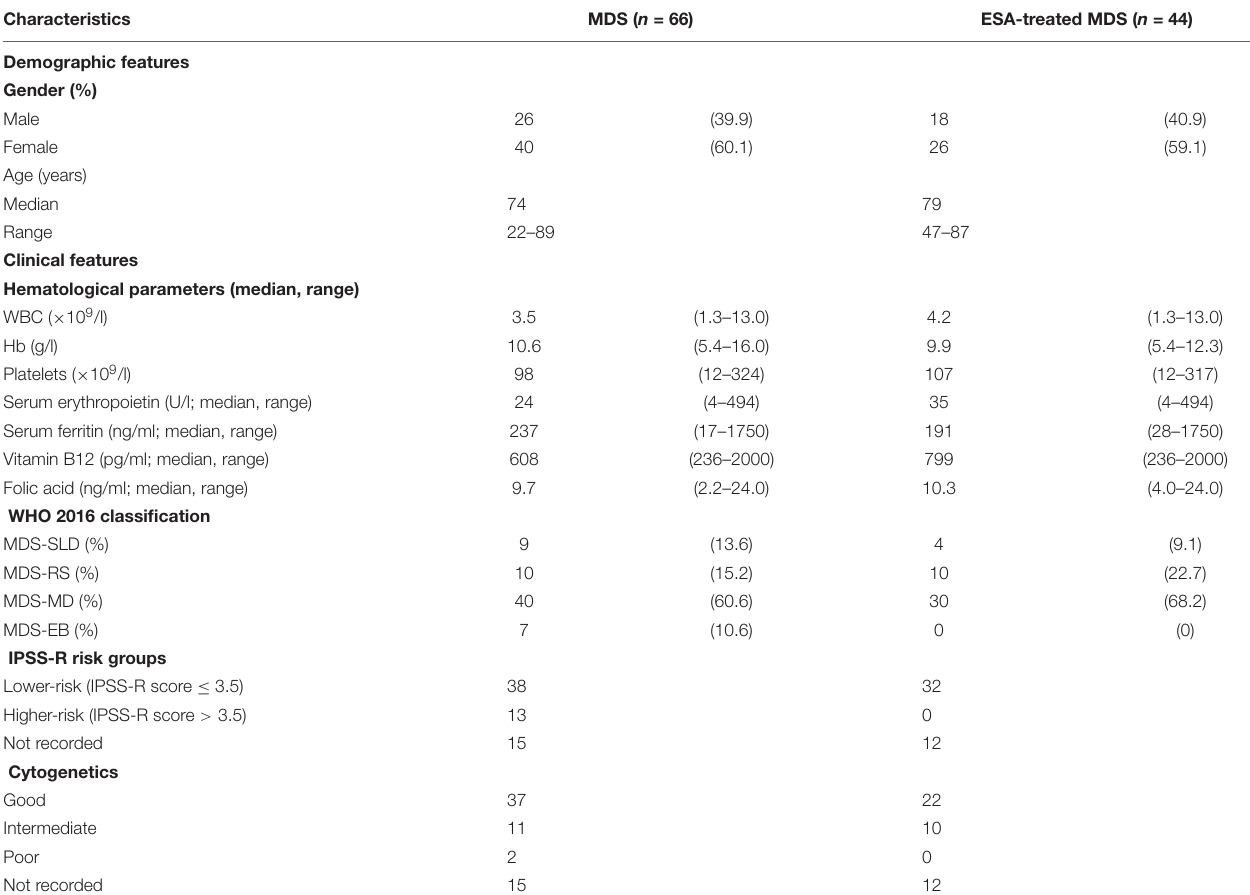
TABLE 1 | Biodemographic and clinical characteristics of MDS patients.